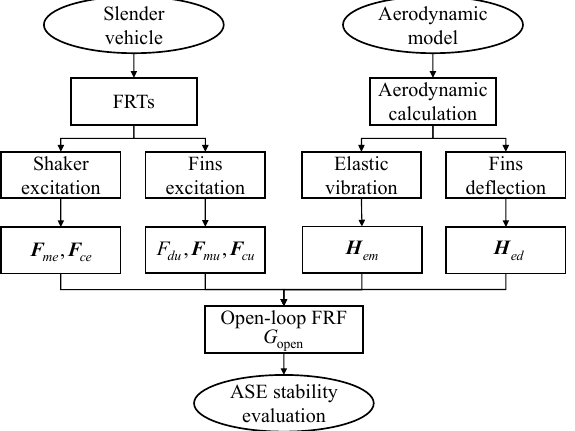
Figure 9. Flow chart of ASE stability